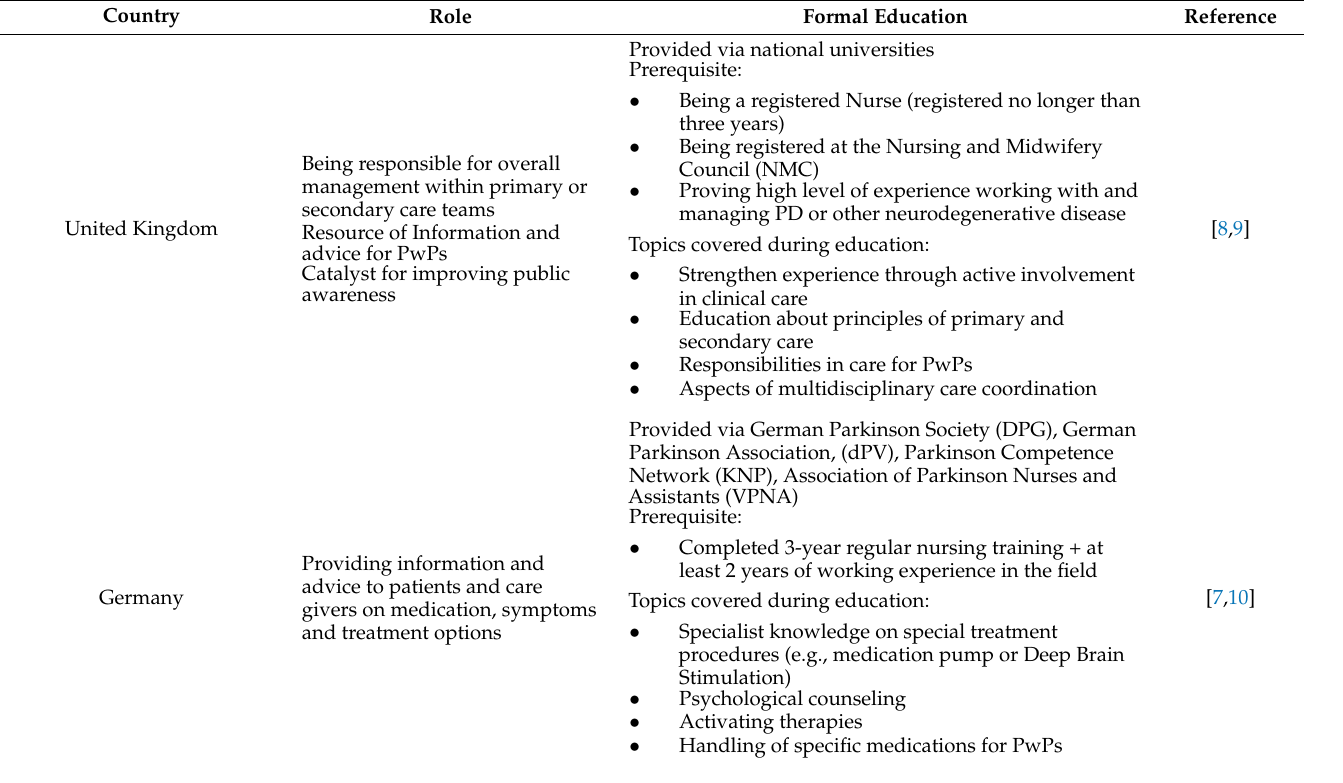
Table 1. Existing Training Opportunities for Parkinson Nurses in different Countries.